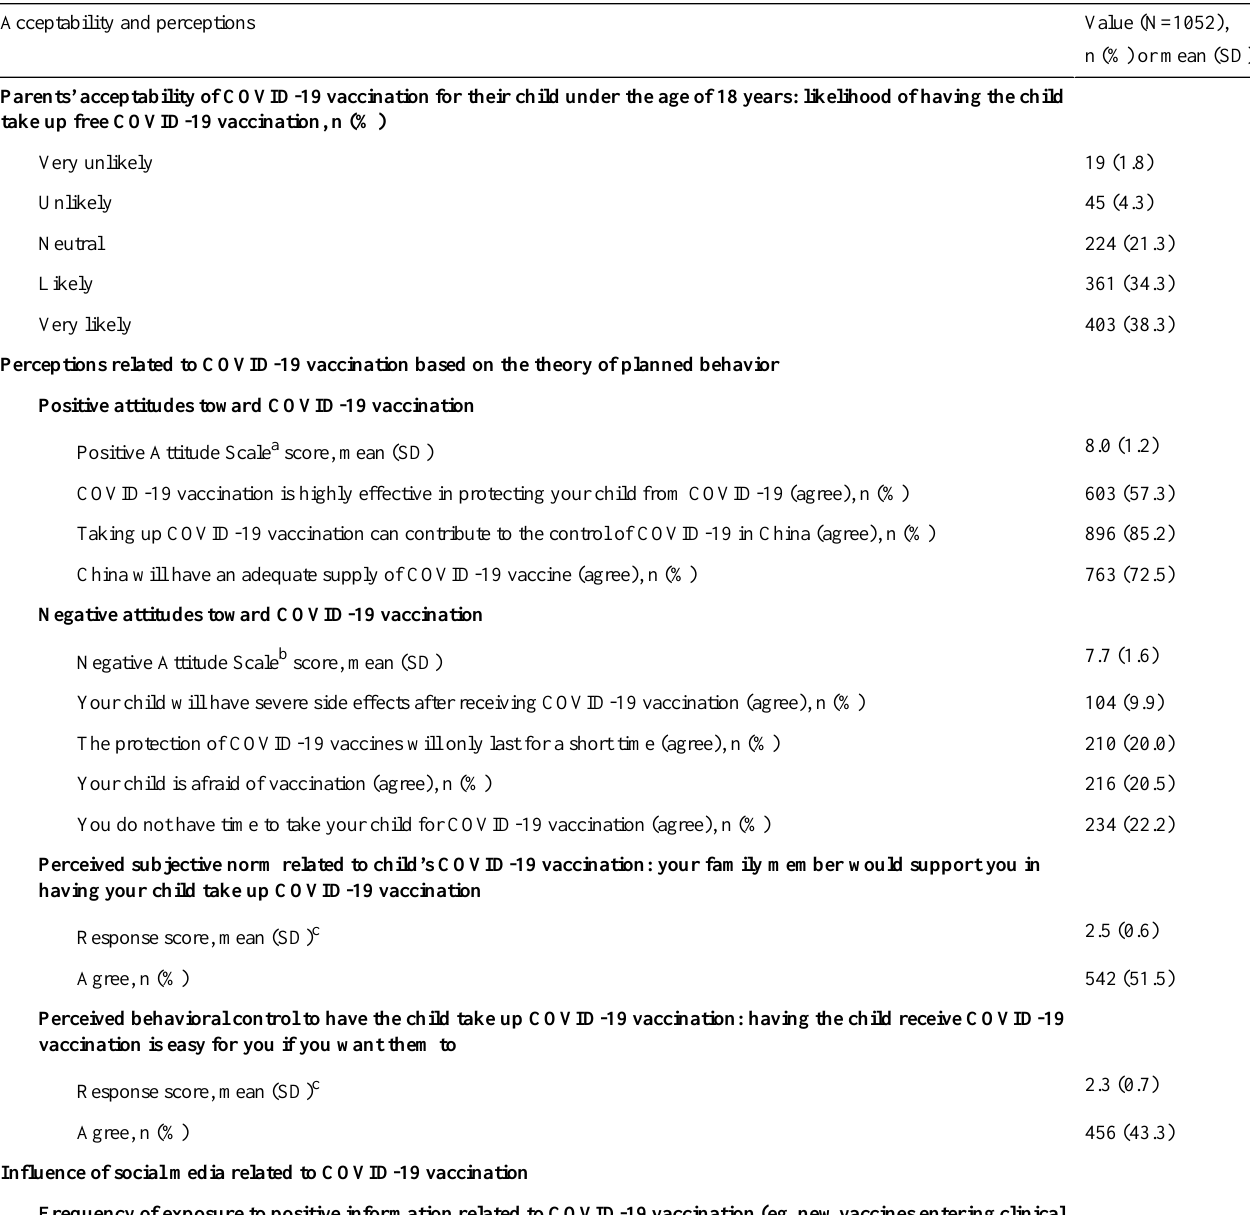
Table 2. Perceptions related to COVID-19